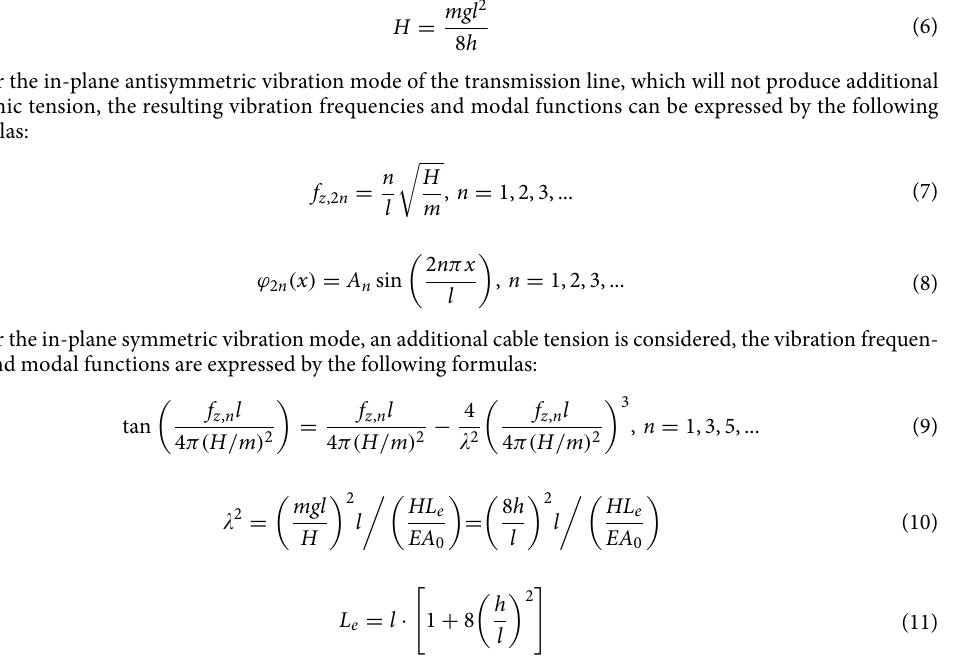
Motion component Vibration frequency